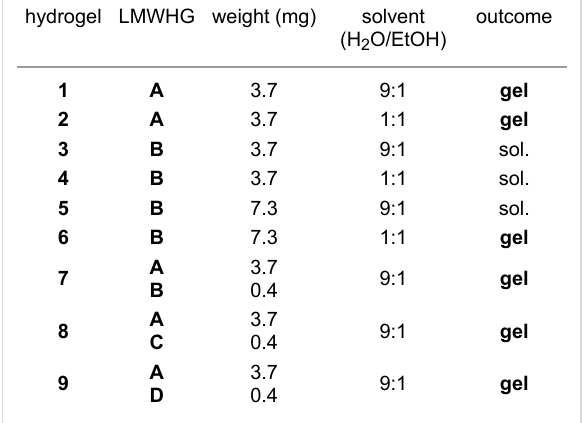
Table 1: Gelling status of the molecules A , B , C and D and of their mixtures. hydrogel LMWHG weight (mg)